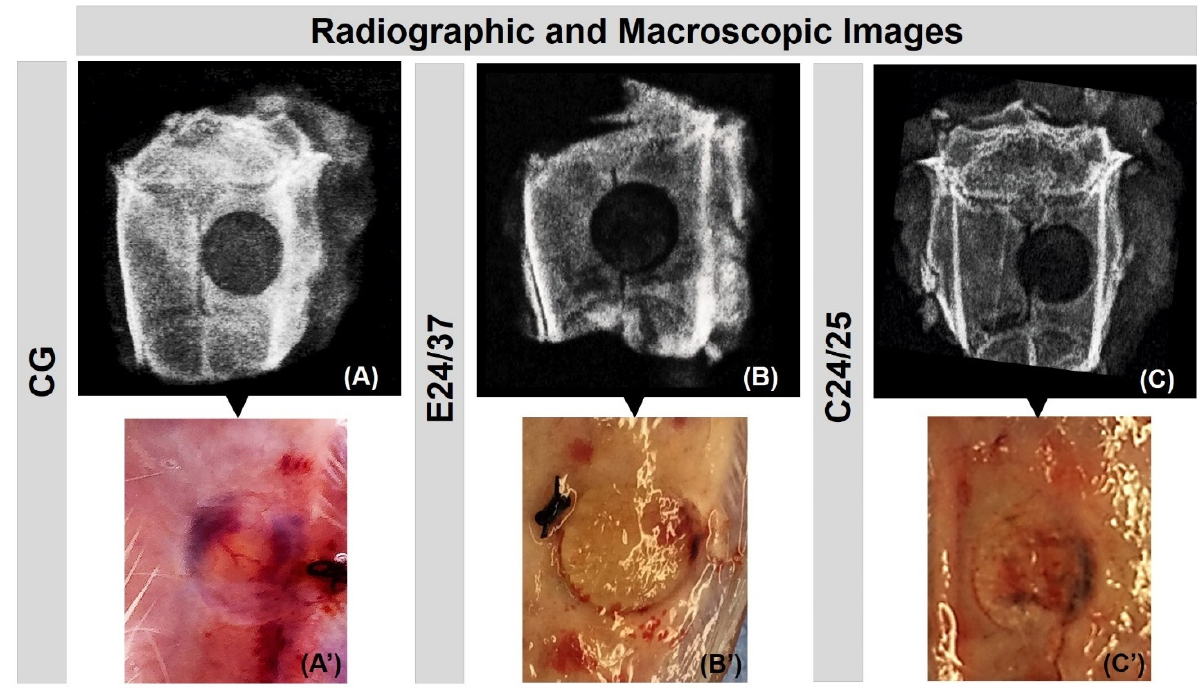
Figure 1. Evaluation of X-ray ( A–C ) and macroscopic features ( A ′ –C ′ ) of defects in the parietal bone rats. Groups: CG ( A - A ′ ); Hydrolyzed elastin matrix for 24 h at 37 °C — E24/37 ( B - B ′ ); Collagen matrix derived from hydrolyzed porcine intestinal serosa at 24 h at 25 °C — C24/25 ( C - C ′ ). All radiographic images show the central radiolucent cavity by removing the bone fragment in the control group (CG) and, in the groups treated with the matrices, the cavity corresponds to the low radiodensity of the biomaterials. Macroscopic images do not show any focus of infection or inflammatory